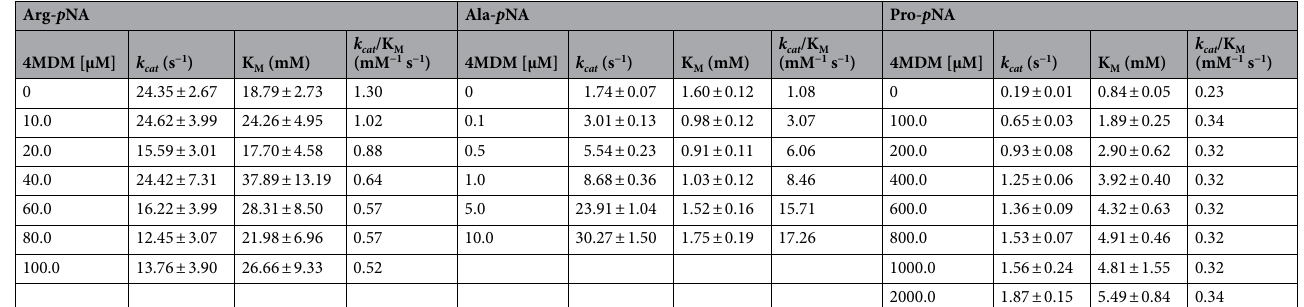
Table 1. Catalytic efficiency ( k cat /K M ) of 4MDM with Ala- p NA, Arg- p NA, and Pro- p NA. k cat and K M values were analyzed using GraphPad Prism 7.0. Data are represented as mean ± standard deviation from six replicates and the coefficient of variation is within 5%.